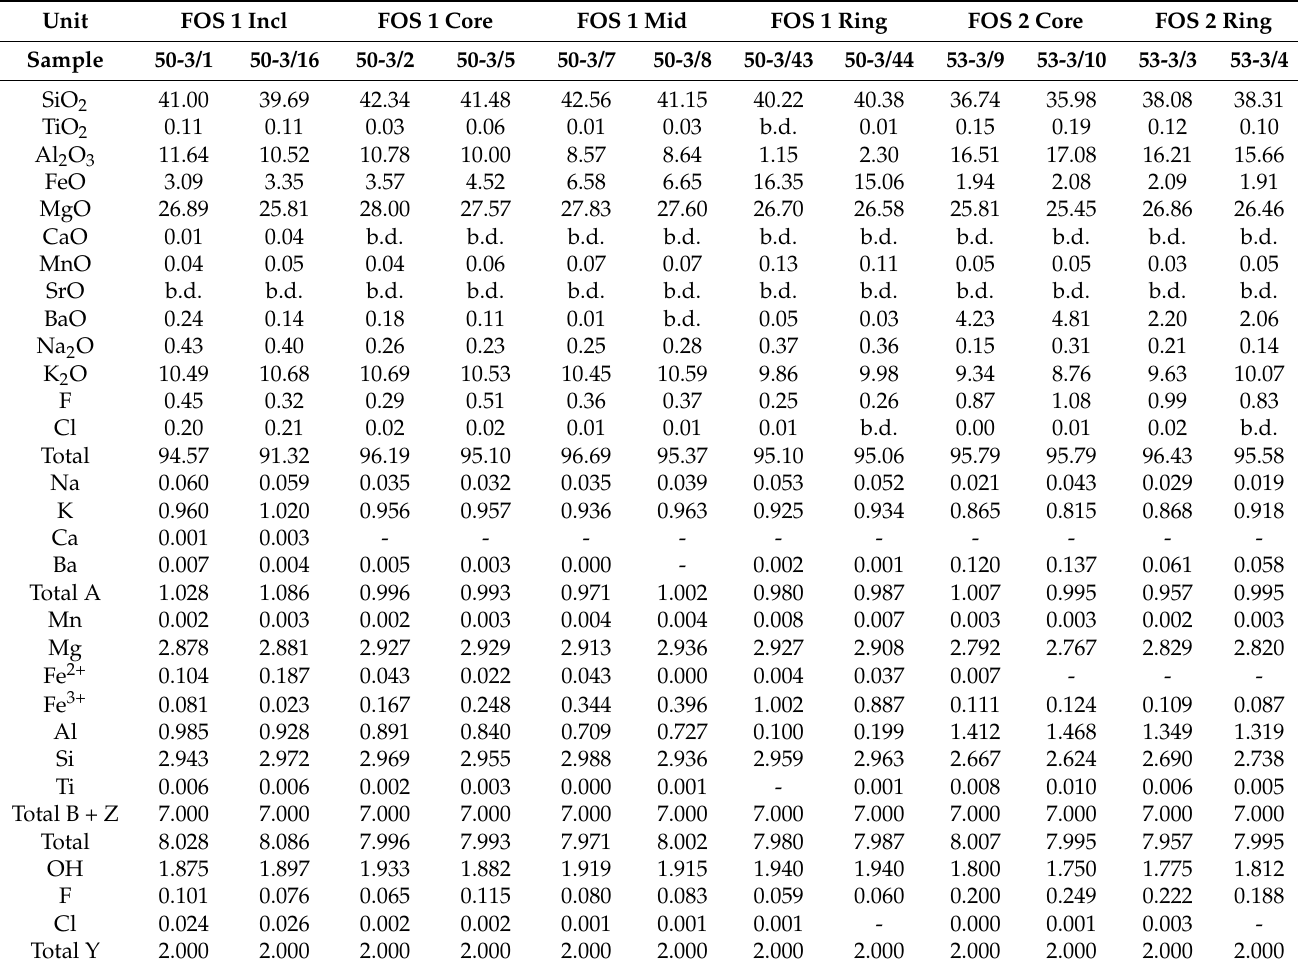
Table 3. Representative compositions of phlogopite from the phoscorites of the Arbarastakh massif. B.d. = below the detection limit. The structural formulae of micas are calculated for seven cations (Z + B). Unit